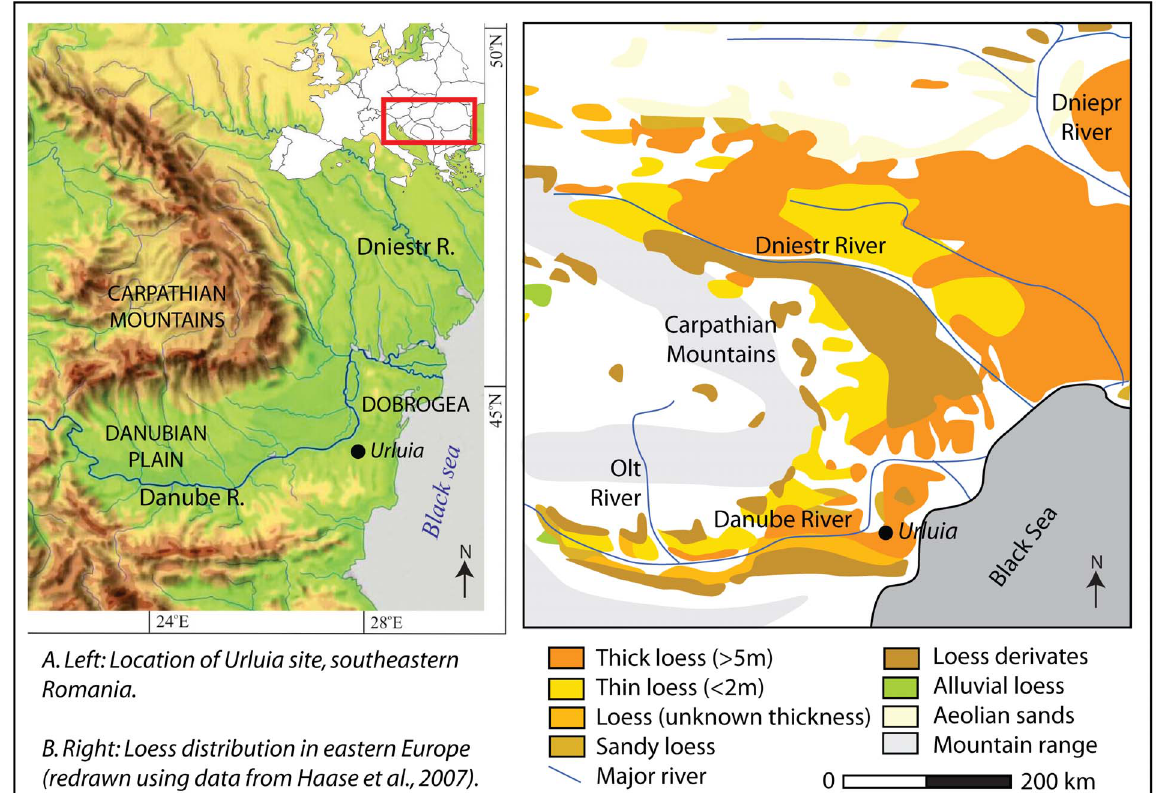
Figure 2. Location of Urluia loess deposit, southeastern Romania (a), and distribution and thickness of loess deposits in the lower Danube region (b; redrawn using data from from [ 57 ] ).